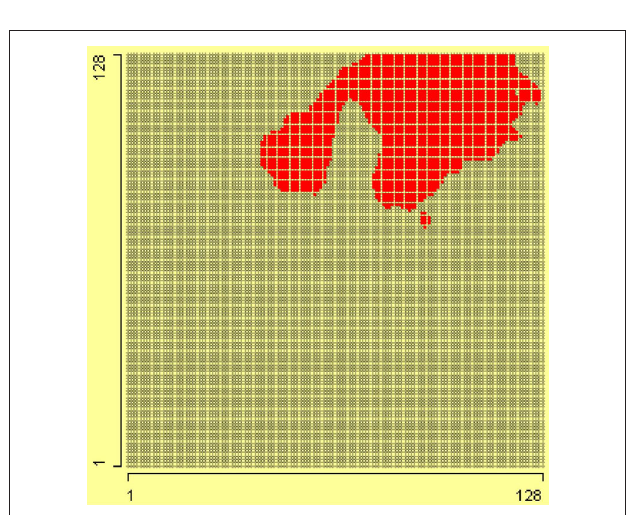
FIgurE 13 | On the grid of 128 × 128, the value 255 of potassium has been selected using a linked